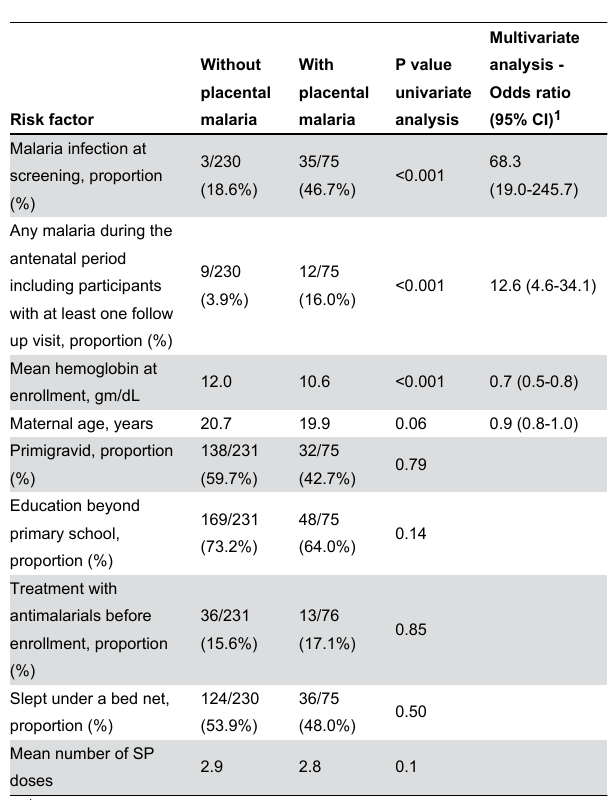
Table 2. Risk factors for placental malaria. Table 3. Associations between the timing of peripheral malaria infection and placental